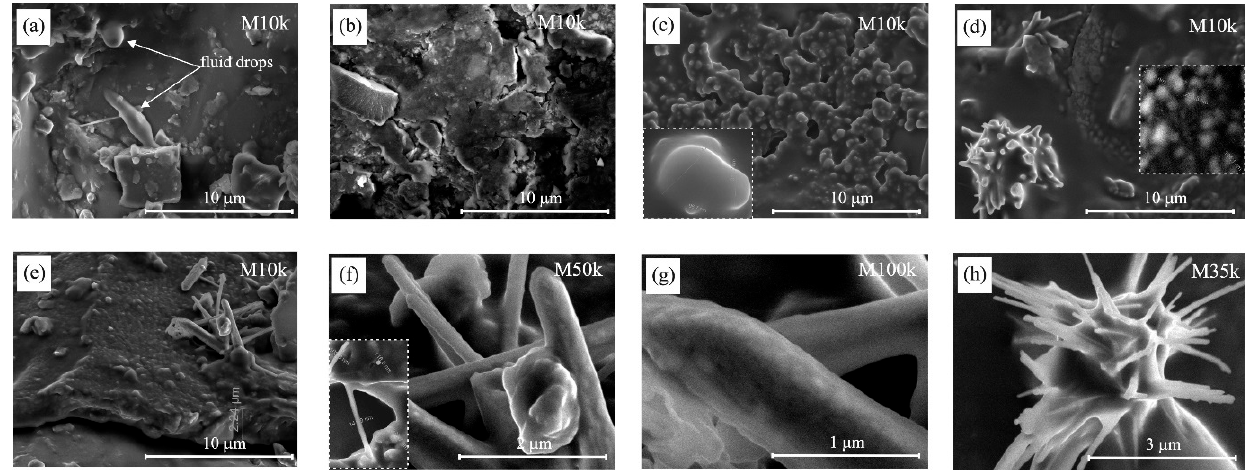
Figure 6. The SEM images of fragments of surface of swollen grains from the charge of coal and its blends with pitches. ( a ) surface of swollen grain in the charge of coal without CTPs, ( b ) surface of swollen grain in the charge of coal blend with CTP86, ( c ) surface of swollen grain in the charge of coal blend with CTP94, ( d ) surface of swollen grain in the charge of coal blend with CTP103, ( e ) crust on the surface of swollen grain in the blend with CTP103, ( f – h ) nano-objects on the surface of swollen grains in the charge of coal blend with CTP103.